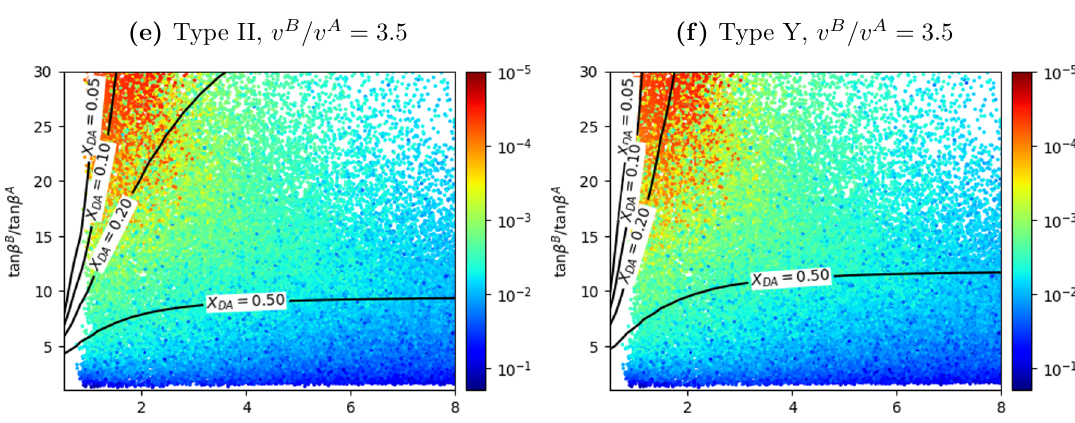
and T (cid:18) . 1 2